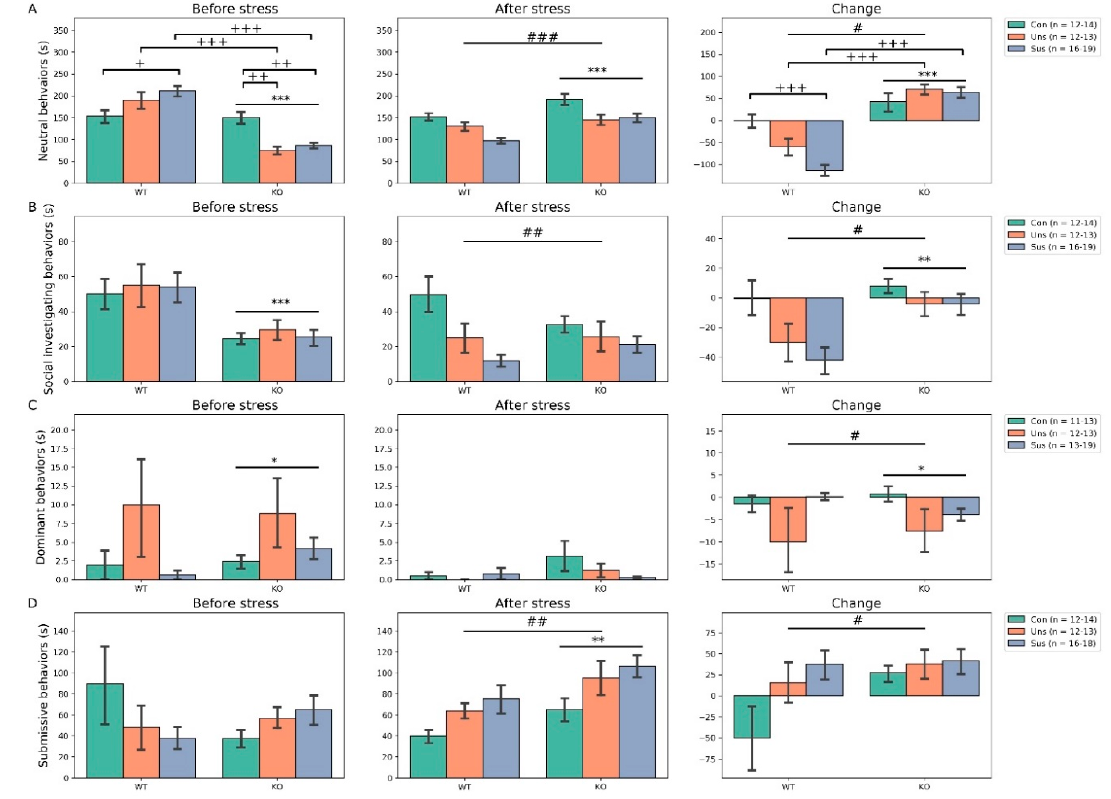
Figure 4. Effects of social defeat on social interaction: ( A ) neutral behavior, ( B ) social investigating behaviors, ( C ) dominant behaviors, ( D ) submissive behaviors. * p < 0.05, ** p < 0.01, *** p < 0.001 for main effect of genotype; # p < 0.05, ## p < 0.01, ### p < 0.001 for main effect of group; + p < 0.05, ++ p < 0.01,